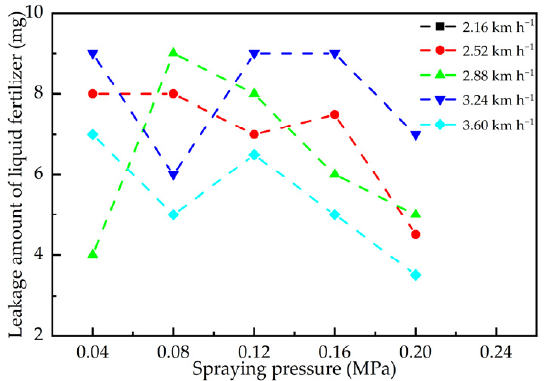
Figure 12. Leakage amount of fertilizer at the same speed and different pressures. As shown in Figure 13, under the same pressure with an increase in speed, the overall leakage amount of fertilizer shows a decreasing trend, and the higher the speed, the smaller the leakage amount of fertilizer. The liquid fertilizer leakage between adjacent operating speeds at the same liquid fertilizer spraying pressure was not measured, so the relationship curve between different operating speeds and liquid fertilizer leakage at the same liquid fertilizer spraying pressure is a straight and dotted line.